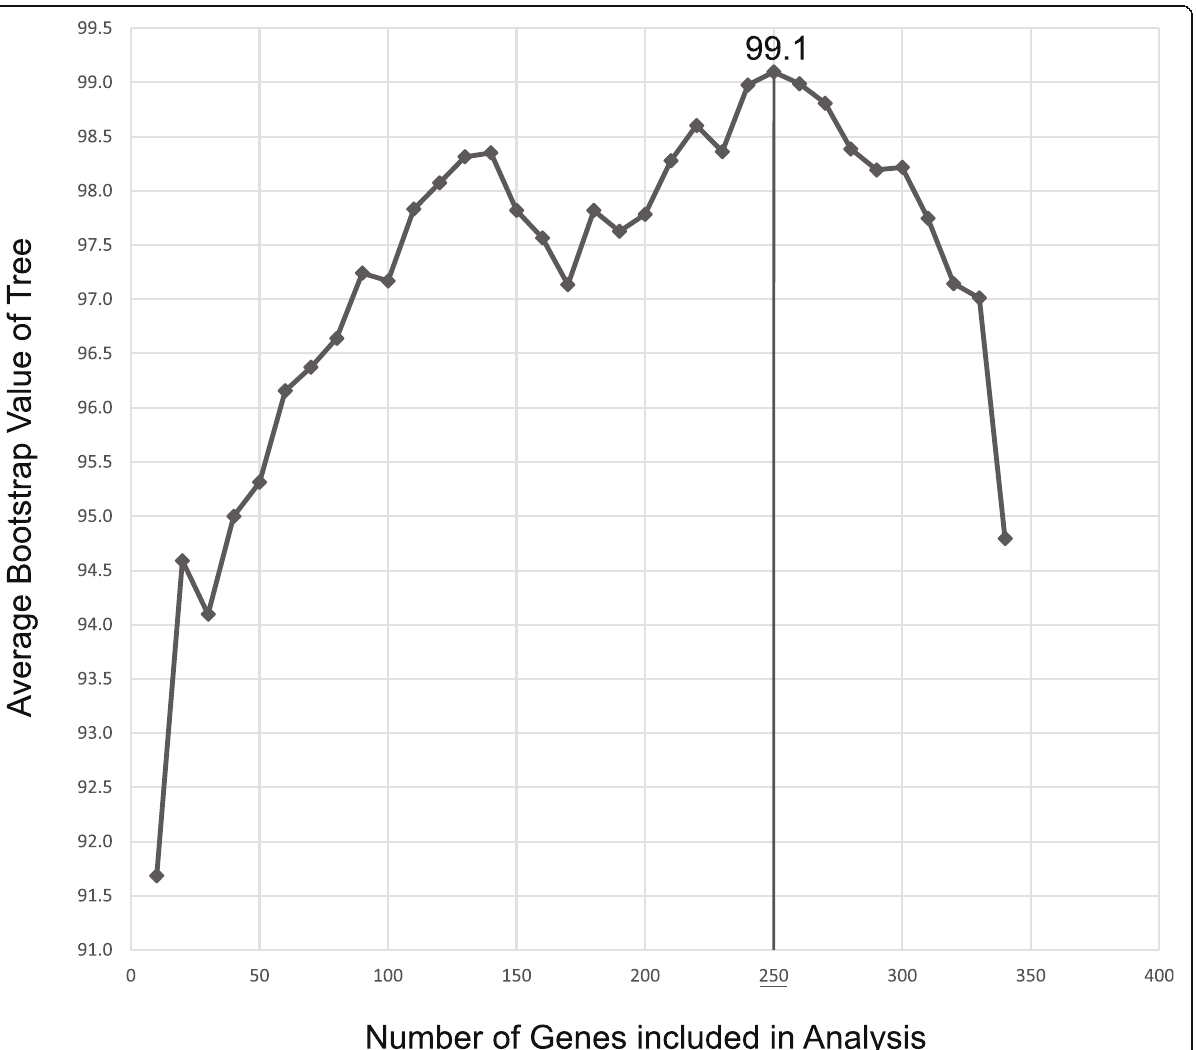
Fig. 1 Correlation of the number of concatenated genes and the average bootstrap value of the resulting phylogenetic tree. The phylogenetic tree of each data point was reconstructed with the concatenated alignment of the selected genes with RAxML using the GTR + G model. Bootstrap values were calculated with the fast bootstrapping option in